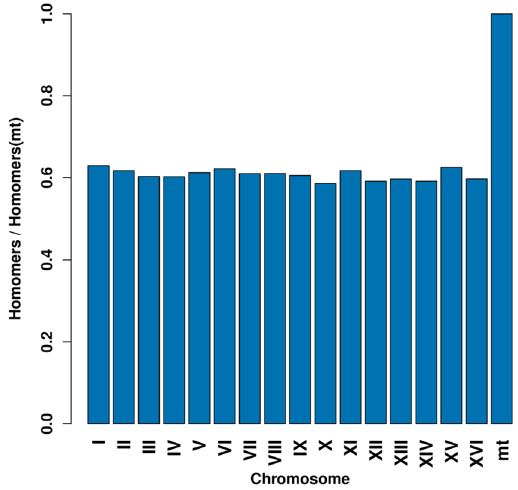
Figure 3. Chromosome homomer rate with respect to that of the mitochondrial genome. Ratios of 5–homomer counts normalized by the chromosome length between each chromosome and the mitochondrial genome